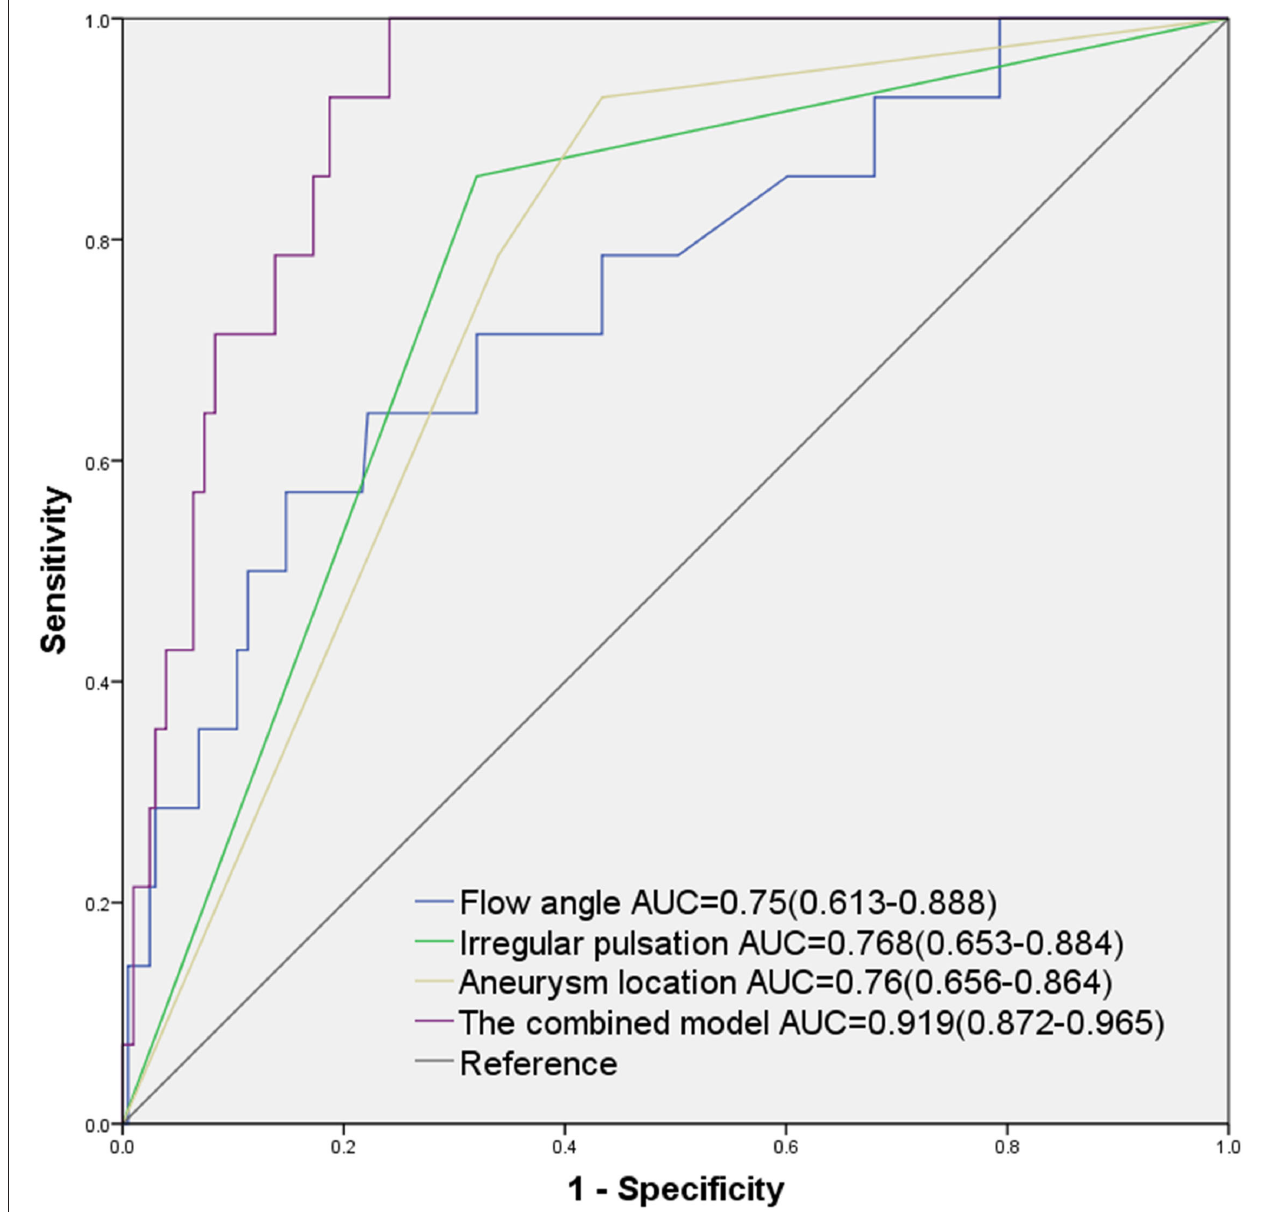
FIGURE 4 | Area under the curves (AUCs) of the predictive value of small aneurysm rupture according to independent